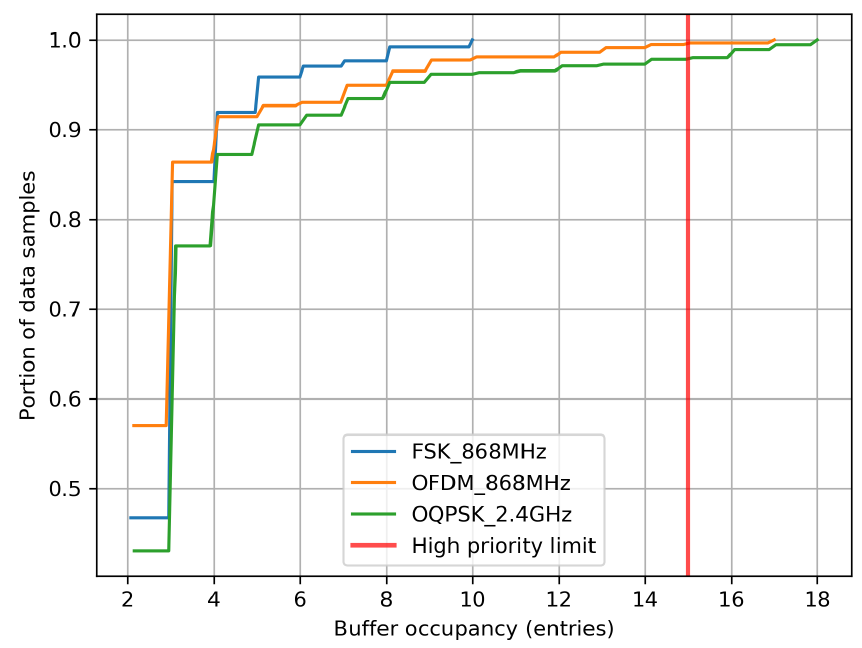
Figure 7. Cumulative Density Function (CDF) of buffer occupancy over the last 15 mins of the experiment. Having more than 15 entries occupied in the buffer (the red line) leads to data packet drops.